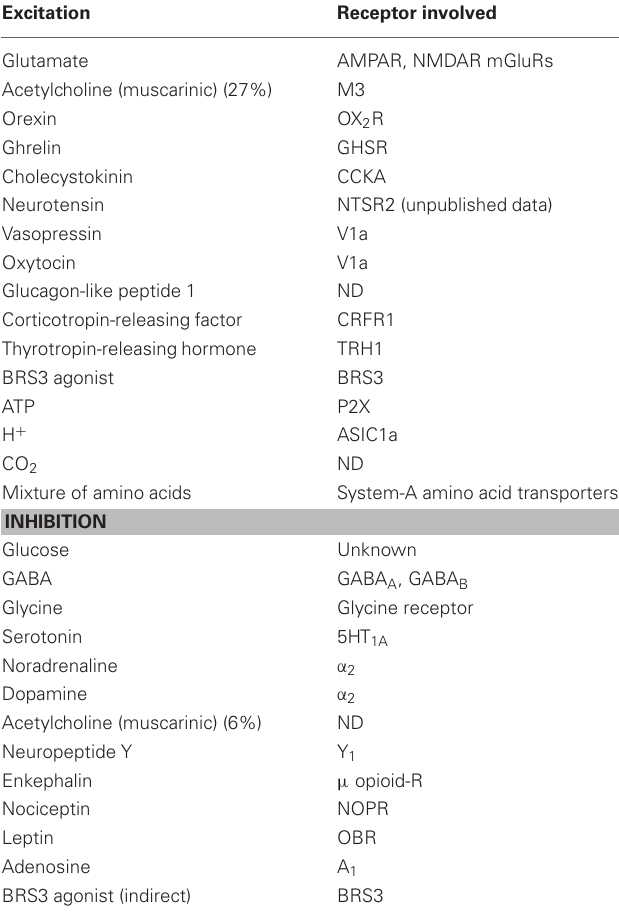
Table 1 | Factors that influence activity of orexin